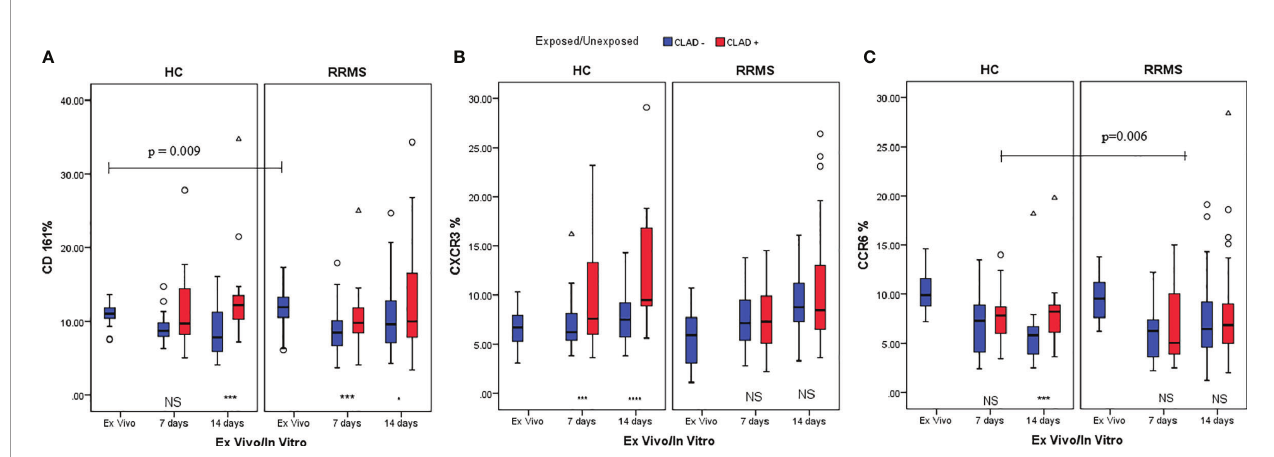
FIGURE 8 | HC and RRMS CD3+CD161+ (A) , CD3+CXCR3+ (B) and CD3+CCR6+ (C) cell population changes at day 7 and day 14, after cladribine treatment, represented as boxplot (median with error bars). NS, non signi fi cant ( p > 0.05) P -values were considered signi fi cant when lower than 0.05 (* p ≤ 0.05, *** p ≤ 0.005, **** p ≤ 0.0001).